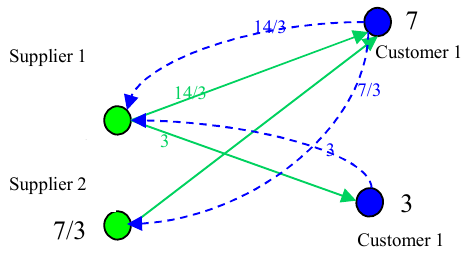
Figure 6. Initial situation.